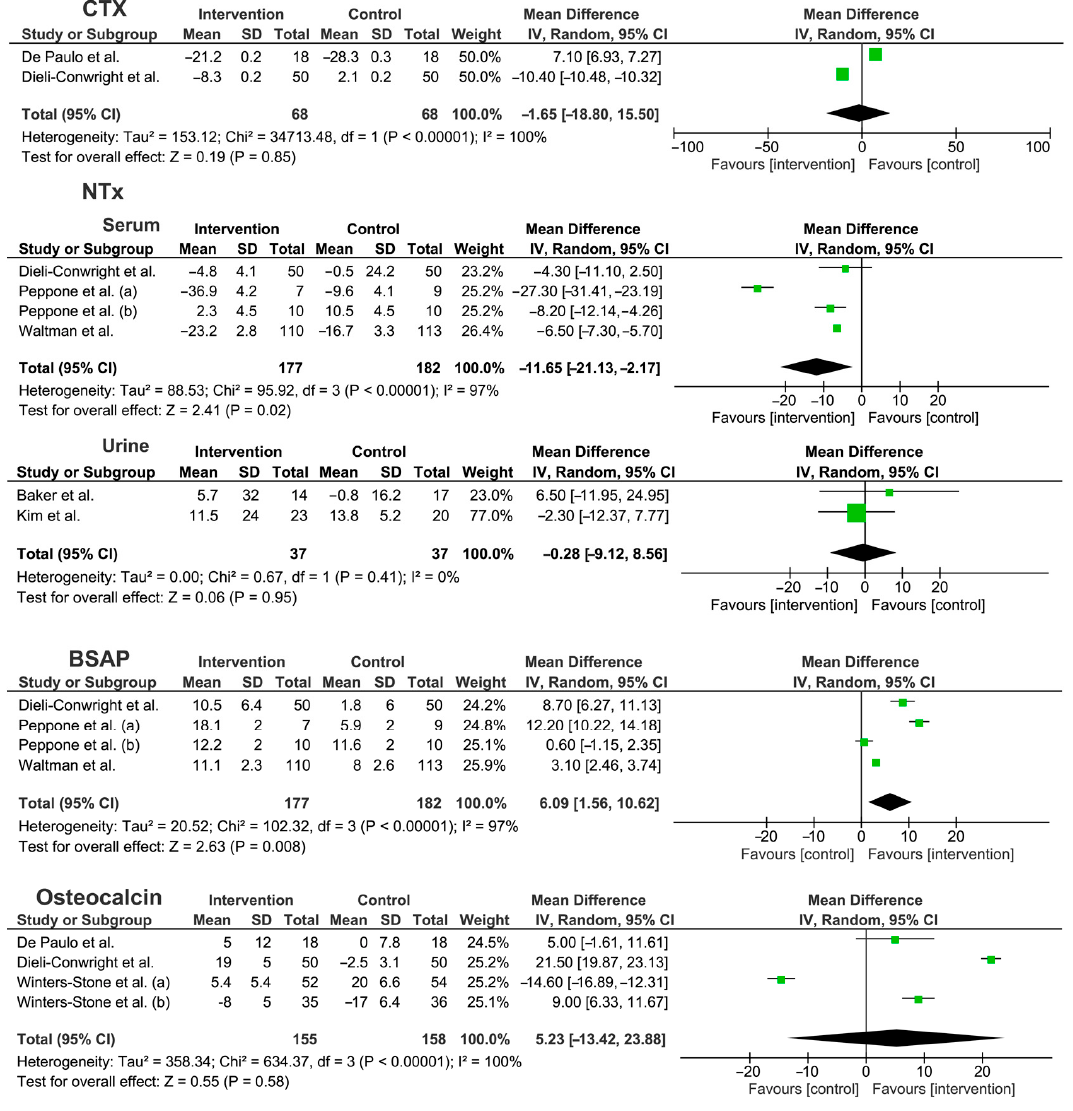
Figure 3. Meta ‐ analysis of the studies included [31–36,38–40]. Abbreviations BSAP: bone specific alkaline phosphatase; CI: confidence interval; CTX: C ‐ telopeptides of type I collagen; NTX: crosslinked N ‐ telopeptides of type I collagen; SD: standard deviation.